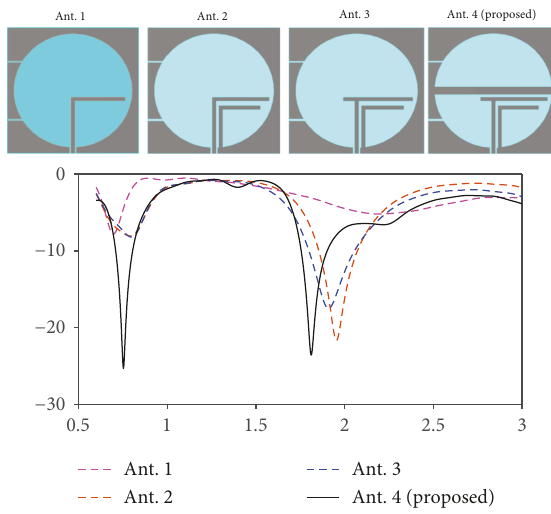
Figure 2: Simulated return loss of di ff erent